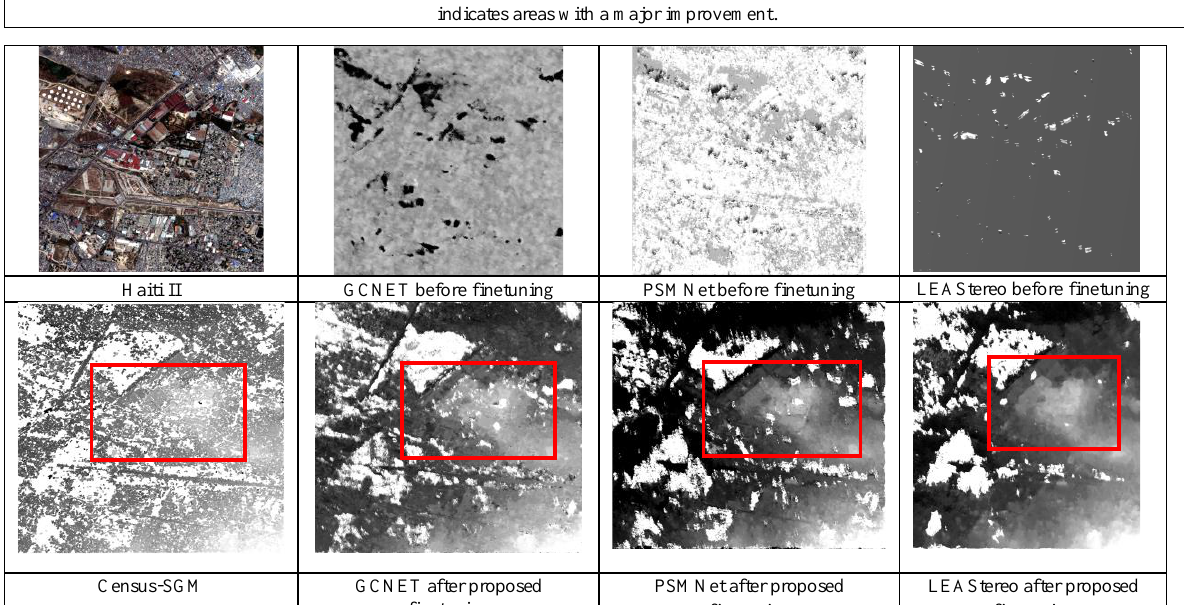
Figure 5. The DSMs from Haiti II study site before and after our proposed finetuning method. The red rectangles indicate areas with major